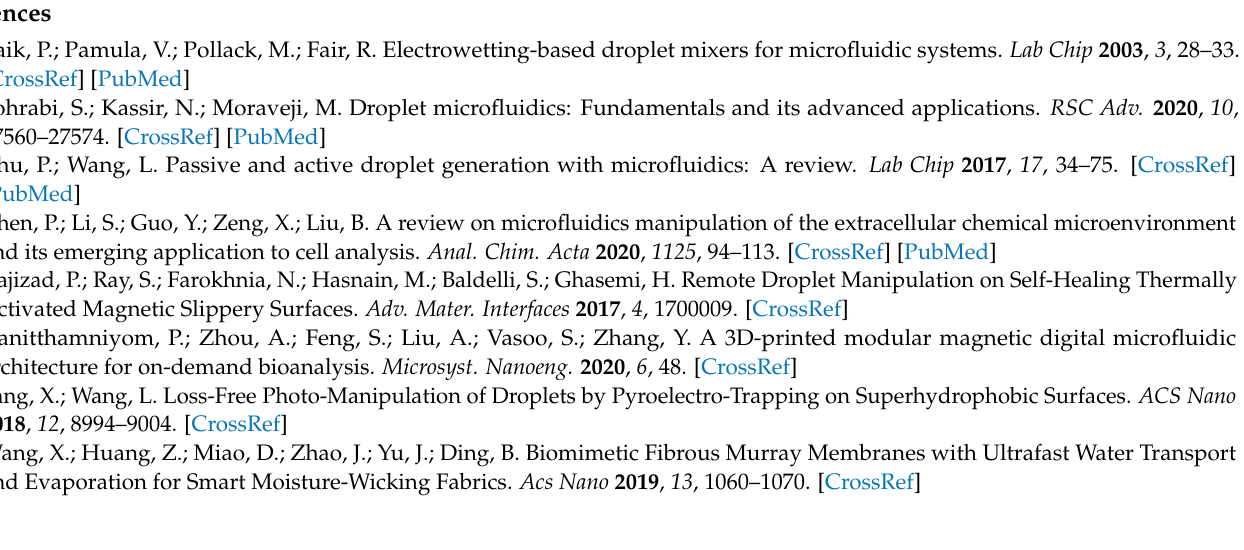
Figure S2: Fitting curve of T n ; Figure S3: Fitting curves of ν max and ν min ; Figure S4: Fitting curve of ν n ; Video S1: Continuous manipulation of